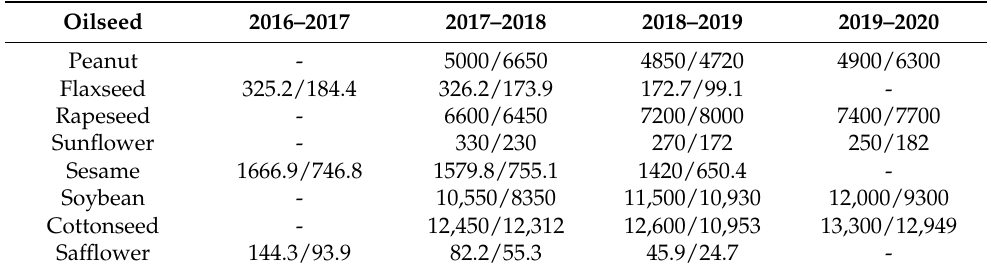
Table 1. Production rate of different oilseeds in India. Data are expressed as: Area ( × 10 3 hectares)/Production ( × 10 3 metric tons). Sources: USDA Official and Ministry of Agriculture,